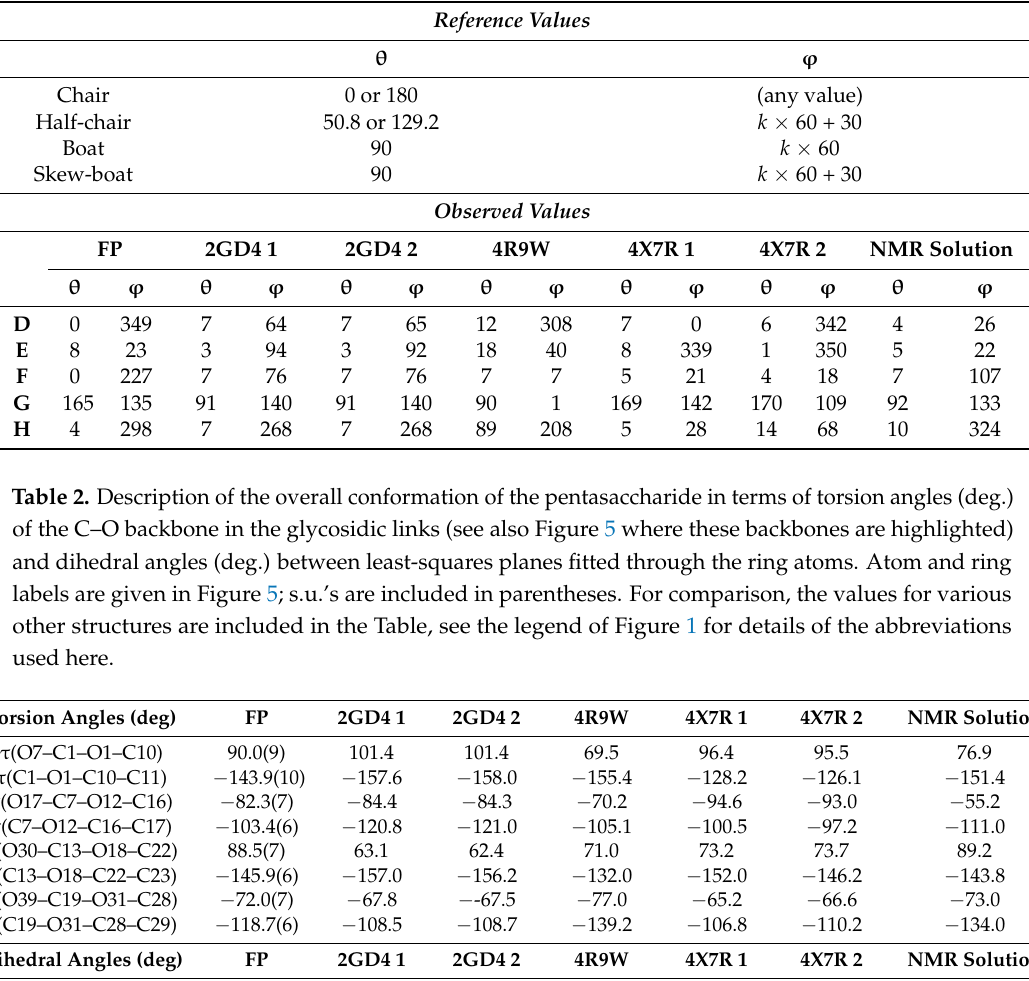
Table 1. Cremer & Pople puckering parameters for the rings in the Fondaparinux structure published here (FP). Parameters for a selection of ideal conformations are included for comparison in a separate section; k is an integer number [27]. For comparison, the values calculated from the published coordinates of a selection of co-crystals of proteins and heparin. These are indicated with their PDB codes: 2GD4 is antithrombin S195A with heparin [5]; 4R9W is platelet factor 4 with heparin [7], 4X7R is wall teichoic acid glycosyl transferase [8]. The last column reports the values calculated from the coordinates of a solution NMR study [28]. 2GD4 and 4X7R contain two crystallographically independent heparin molecules; values for both are included.